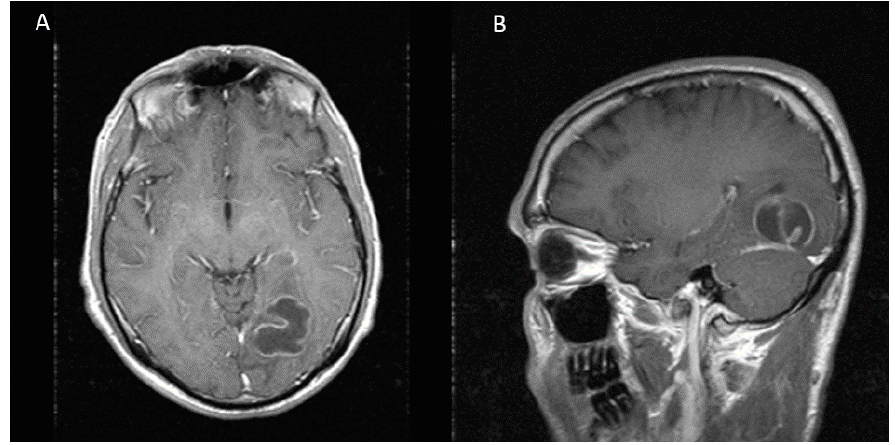
Figure 1. MRI showing a multilobulated and multiseptated lesion of 31 × 31 × 26 mm with peripheral enhancement in the left occipital lobe. ( A ) Axial view ( B ) Sagittal view.